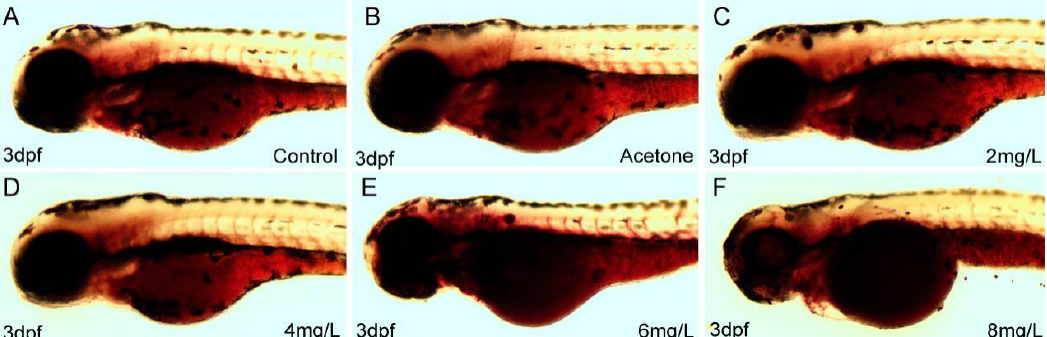
Figure 3. Oil red O (ORO) staining of representative larvae is shown in the left lateral view following different treatments at 3 dpf. A : Control larvae at 3 dpf; B : Vehicle control larvae treated with 0.05 mL/L acetone at 3 dpf; C : 2,4-DNT 2 mg/L-treated larvae at 3 dpf; D : 2,4-DNT 4 mg/L-treated larvae at 3 dpf; E : 2,4-DNT 6 mg/L-treated larvae at 3 dpf; F : 2,4-DNT 8 mg/L-treated larvae at 3 dpf. The pictures were taken with the stereomicroscope in 5× magnification